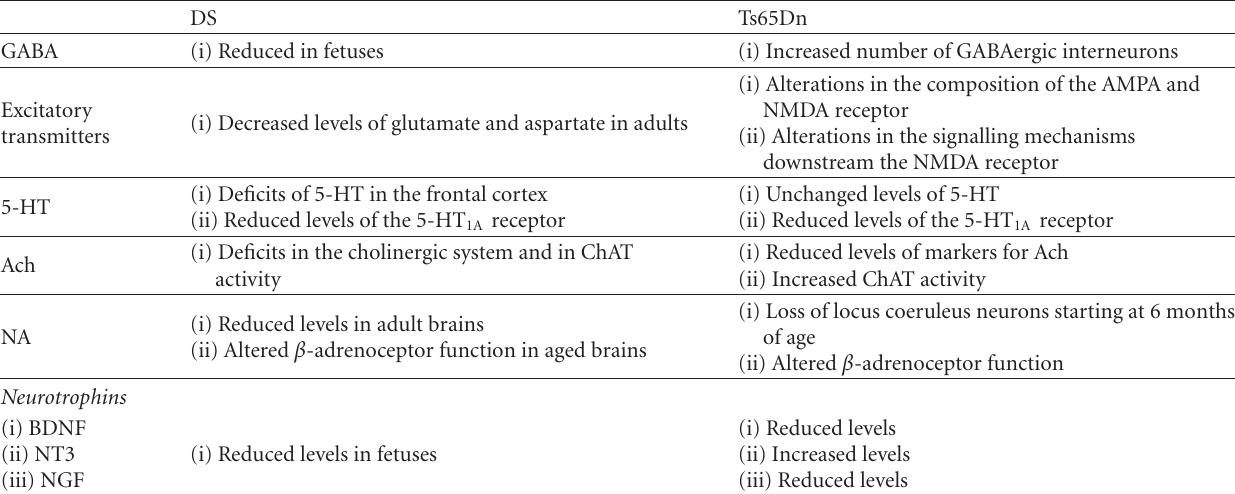
Table 4: Neurotransmitter and receptor alterations in DS and in the Ts65Dn mouse model of Down